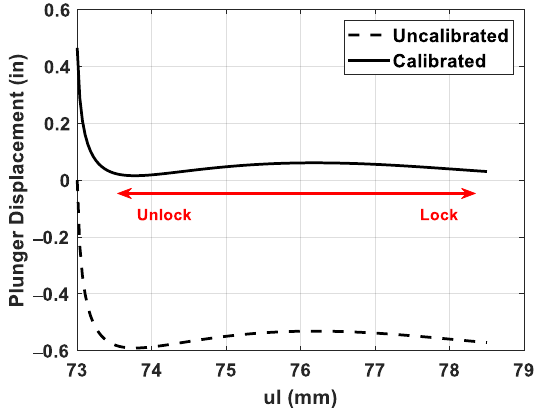
Figure 12. Plunger displacement from Down Lock to Up Lock.